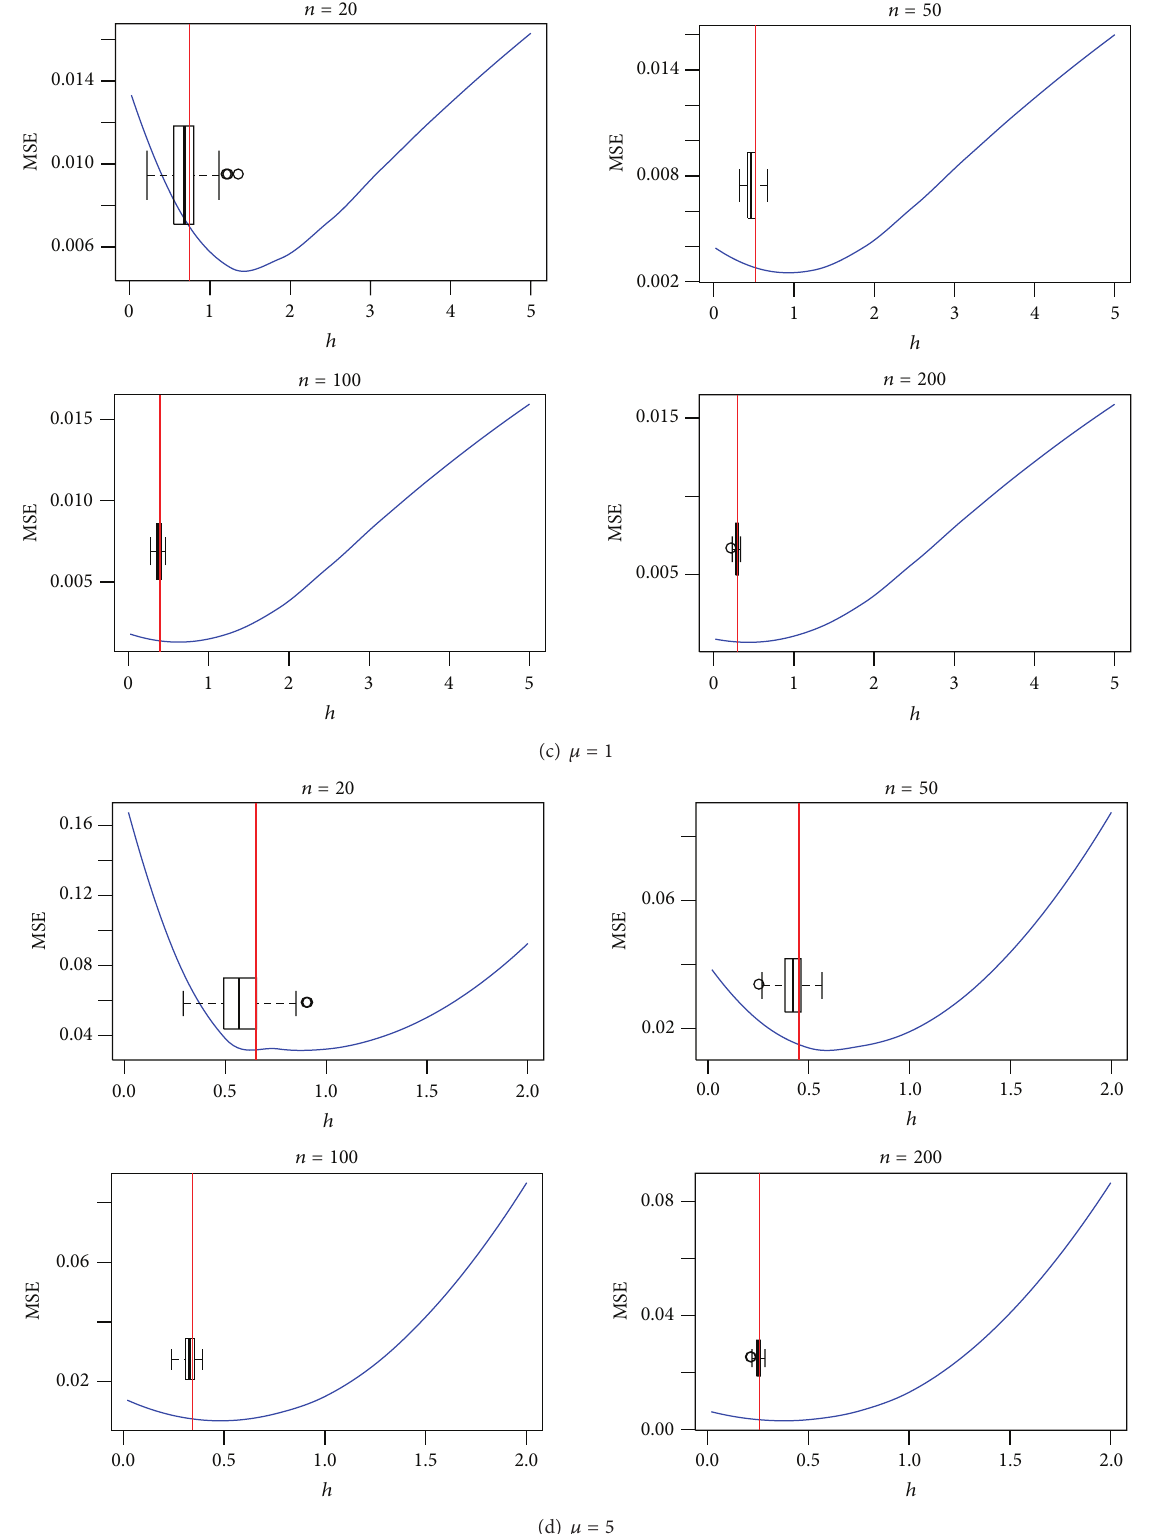
̂𝑈 Figure 2: The bandwidth for 2 when underlying distribution is Normal with mean standard deviation √